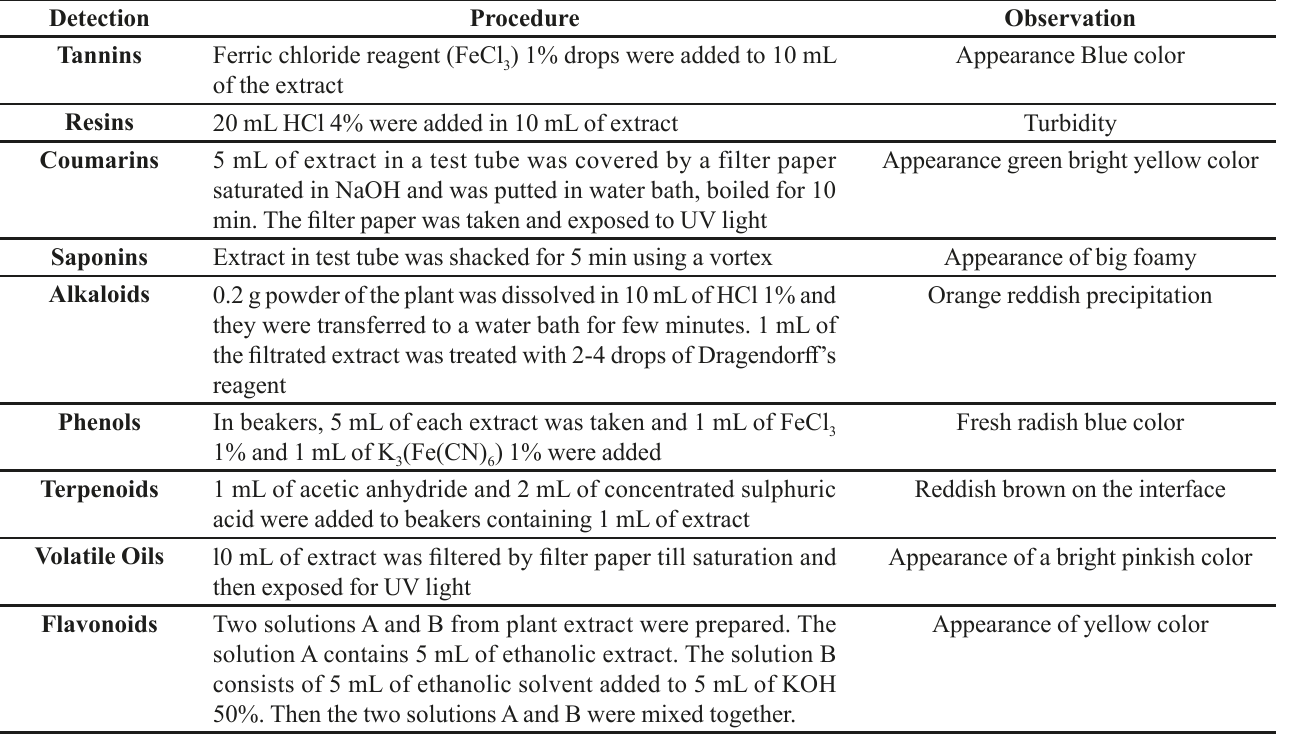
TABLE I - Protocols for phytochemical screening of n -hexan extract of the leaves of Morus nigra Morus nigra